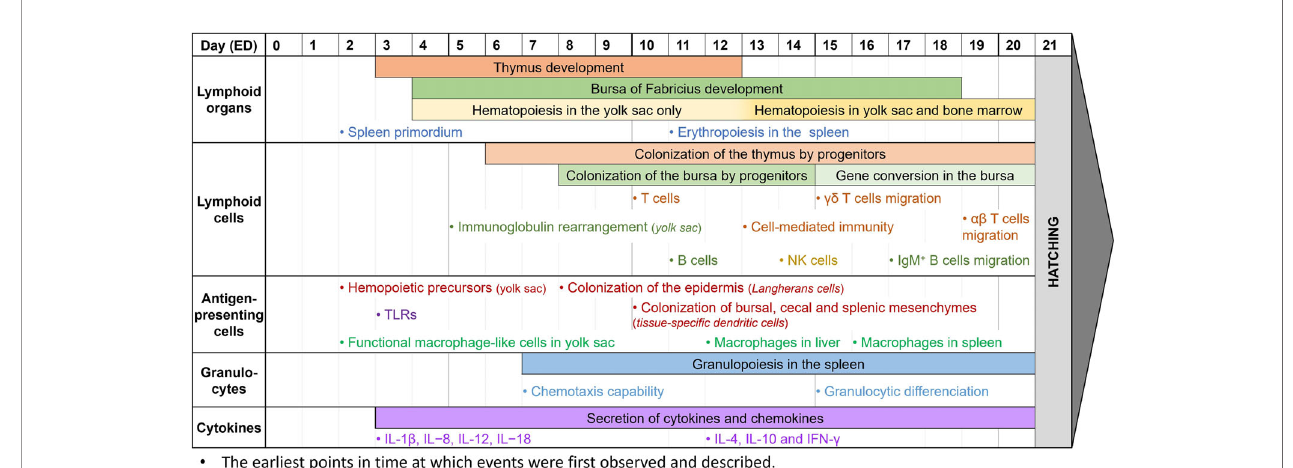
FIGURE 2 | Observed immune system features during chicken embryogenesis. Caveat: This fi gure summarizes observations reported in the scienti fi c literature. They correspond to speci fi c studies each performed at speci fi c time points and do not represent the extent of immune system features over the embryogenesis. Thus, it cannot be interpreted as an accurate depiction of the immune system development in ovo, since most papers do not cover the entire development